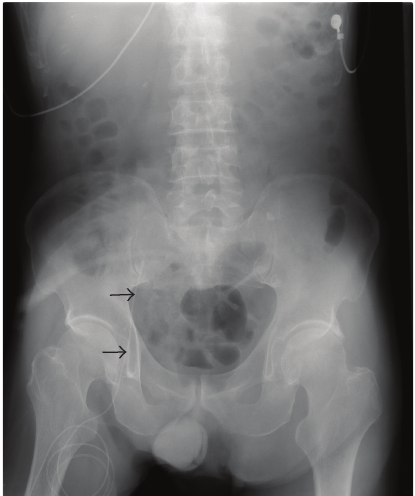
Figure 1: A plain radiograph confirms the position of the catheter.